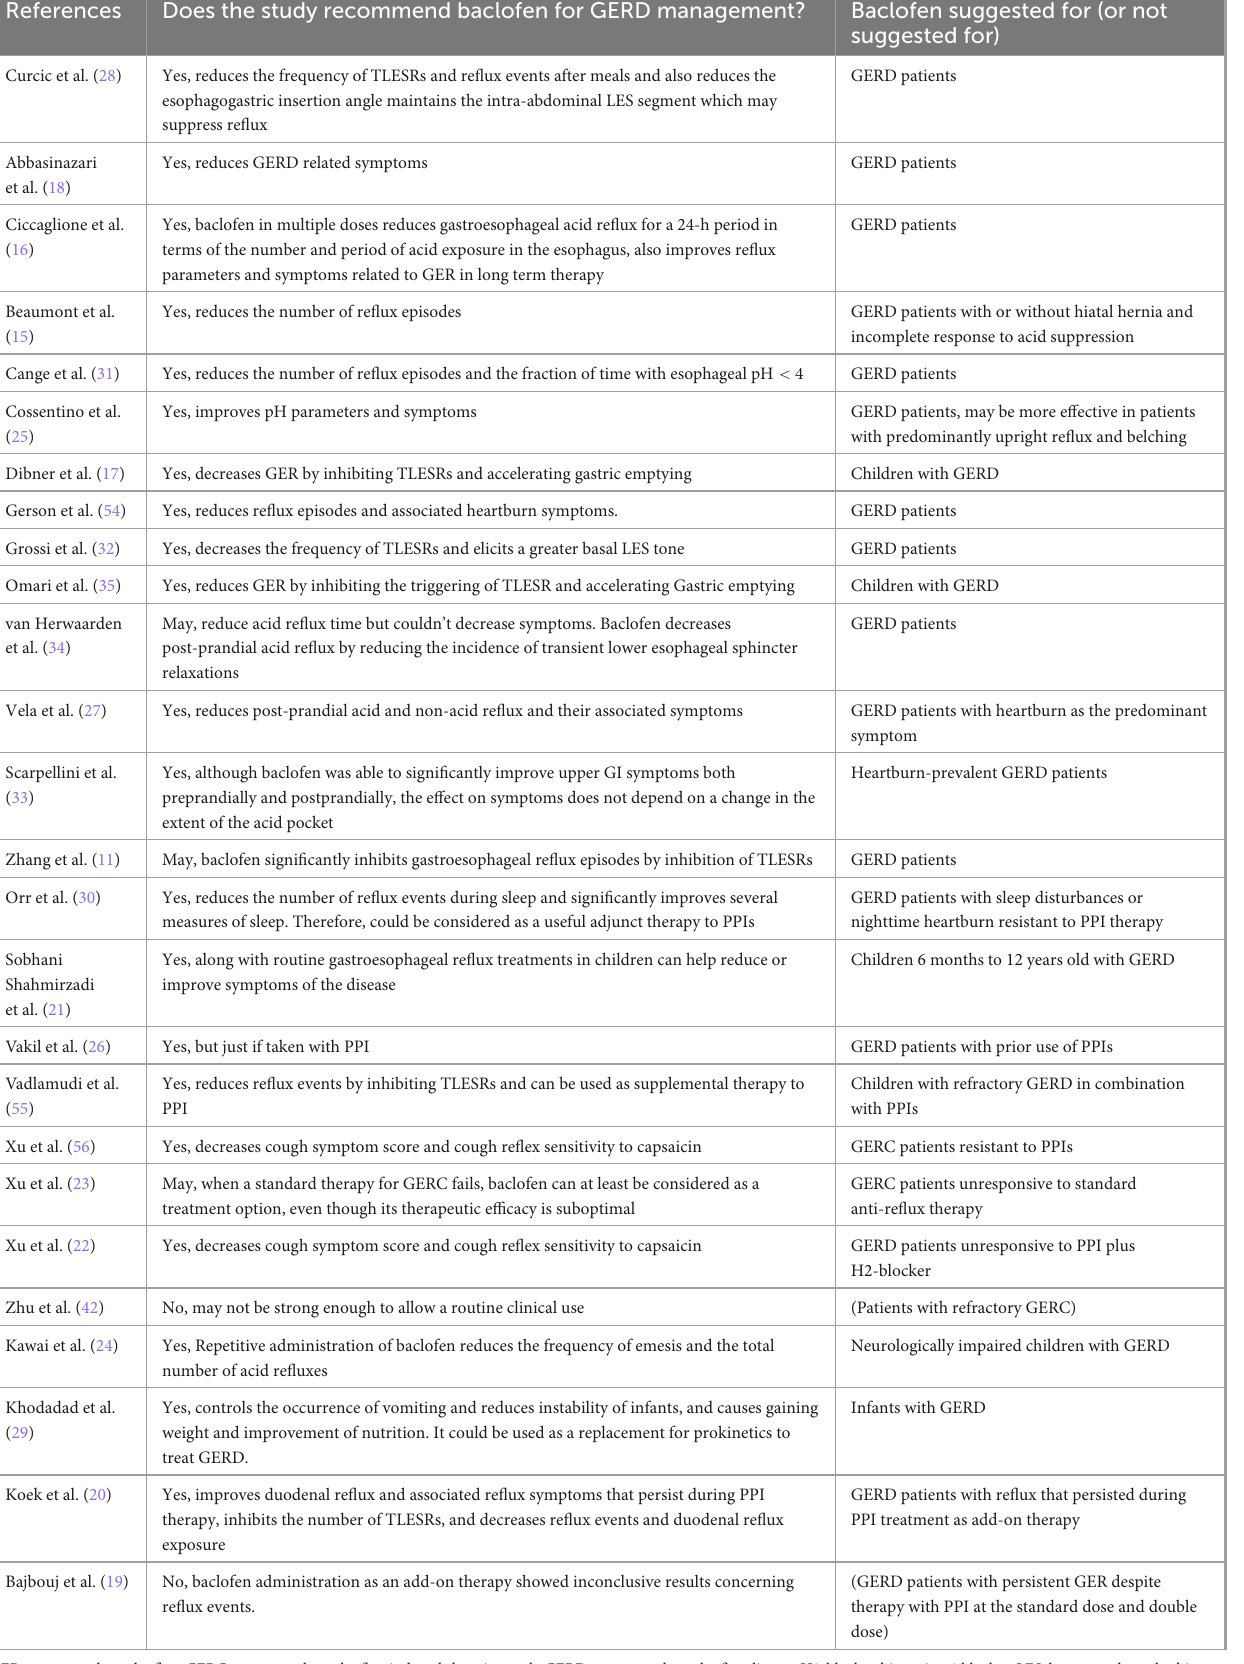
TABLE 9 Feasibility of using baclofen in the treatment of